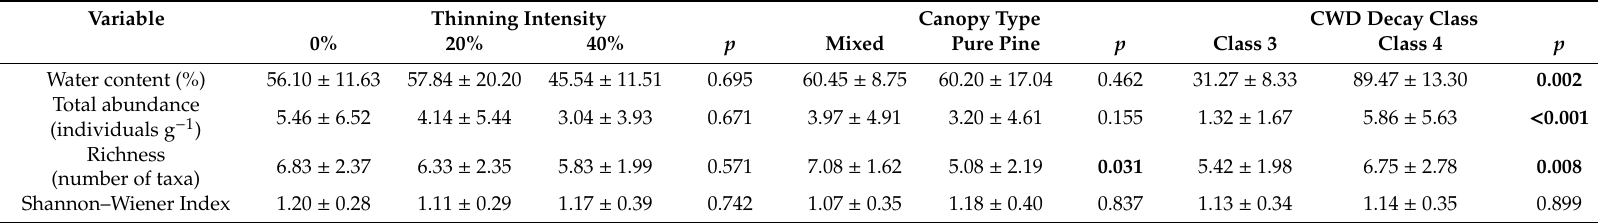
Table 5. Mean and SE number of captured individuals per gram of CWD in di ff erent treatments of thinning intensity, canopy type, and CWD decay class (significant di ff erences at p < 0.05 in bold, n =